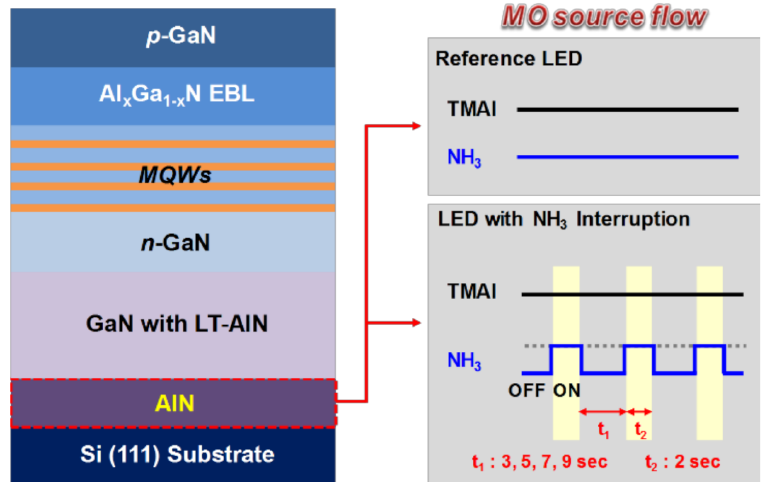
Figure 1. Schematics of light-emitting diodes (LEDs), including the sequence of all growth steps